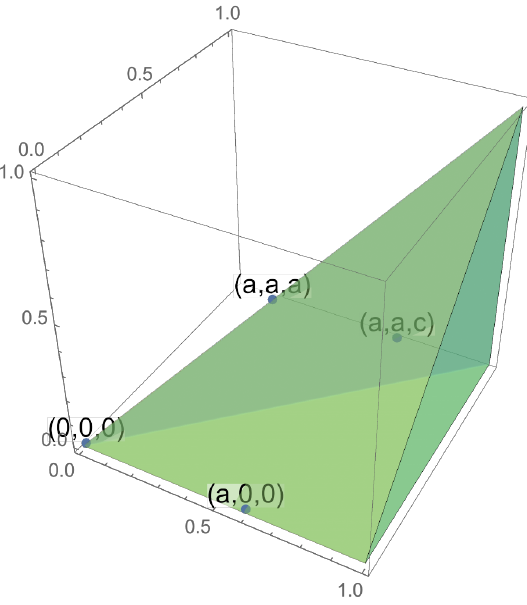
Figure 7 . Portion of the fundamental domain of the group O (3) × O (3) in M = R 9 spanned by the (3 , 3) representation τ . The variables a , b , c have been restricted in the interval between 0 and 1. Points enjoying residual symmetries have been